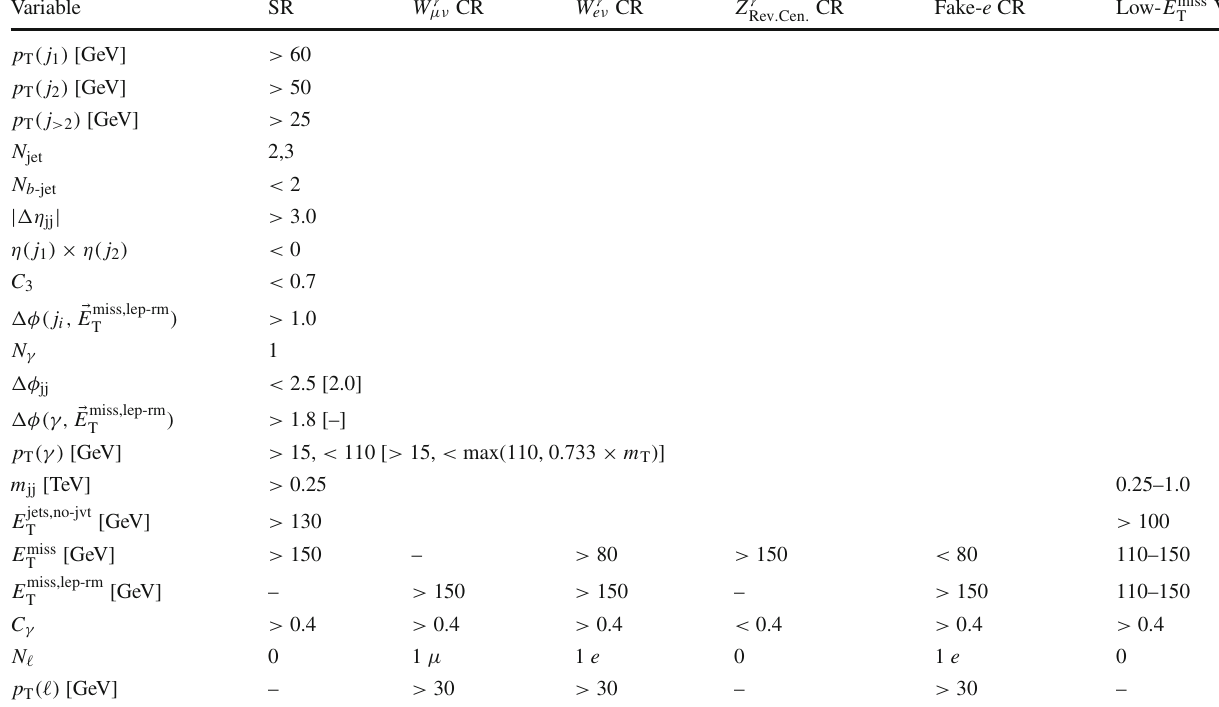
VR definitions E miss,lep-rm since no lepton is present. The m T T variable is defined in Sect. 6.4. When the same requirement is applied to multiple regions, this is reported once in the corresponding row of the table, centred across columns, and is considered to be valid in γ CR, and Low- E miss Rev . Cen . T